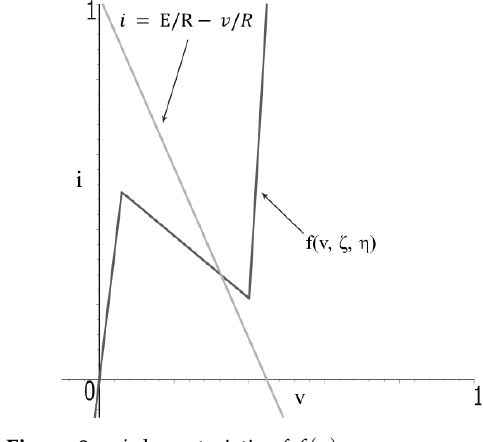
Figure 8. v - i characteristic of f ( v ) .